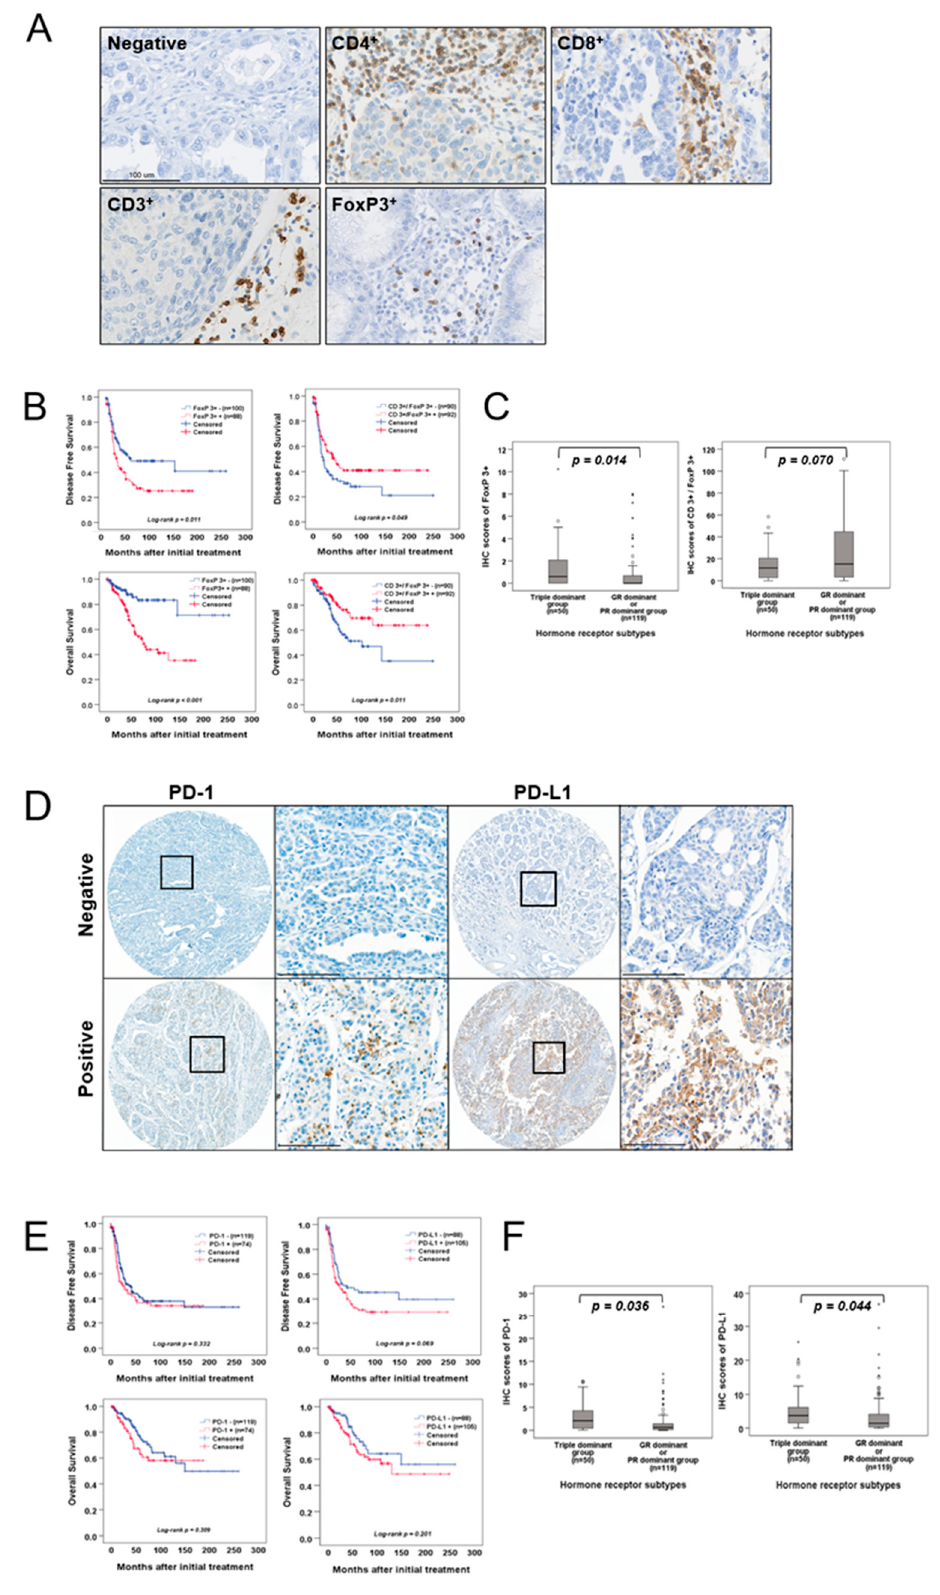
Figure 3. PD-1 and PD-L1 expression in EOC and their association with tumor-infiltrating lymphocytes and EOC subgroups clustered by hormone receptor expression pattern. ( A ) Representative immunohistochemical images of CD4 + , CD8 + , CD3 + , and FoxP3 + TILs in EOCs. The TILs were observed in cancer stroma (scale bar: 100 µ m). ( B ) DFS and OS of patients with EOC were based on FoxP3 + TIL infiltration level and CD3 + /FoxP3 + ratio. ( C ) A boxplot of FoxP3 + TIL infiltration